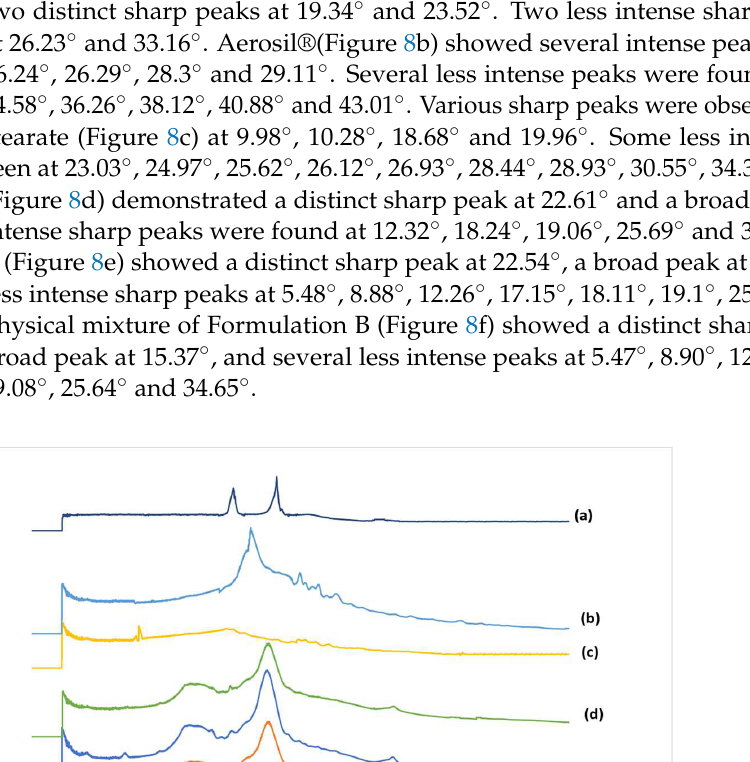
Table 3. The percentage of curcumin contained in commercial curcumin powder, Formulation A, Formulation B, Longvida ® and Nacumin ® (mean ± SD, n = 6).